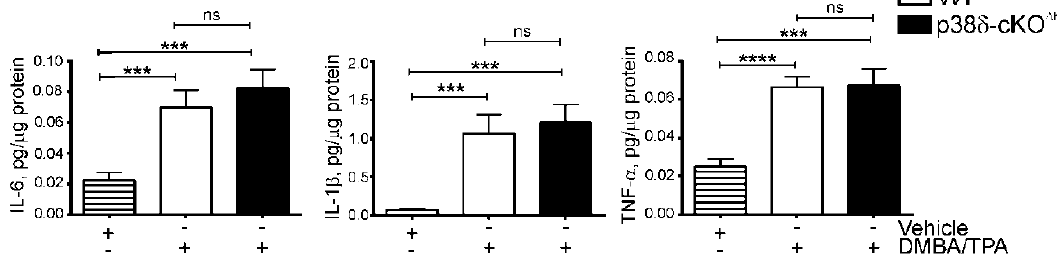
Figure 2. Keratinocyte-specific p38 δ deletion does not affect induction of inflammatory cytokines in response to a short-term DMBA/TPA regimen. Sets of WT and p38 δ -cKO ∆ K littermates of both sexes were subjected to a topical short-term DMBA/TPA treatment as detailed in the Materials and Methods or treated with acetone vehicle. Total skin lysates were isolated from full-thickness dorsal skin of mice (acetone vehicle control: n = 8; DMBA/TPA: n = 20 (WT) and n = 17 (p38 δ -cKO ∆ K )) 2 h after the final TPA treatment, and the levels of protein expression of the indicated cytokines were analyzed using ELISA. Results are shown as mean ± SE. *** p < 0.001, **** p < 0.0001; ns, not significant; vehicle treated group included mice of both genotypes.